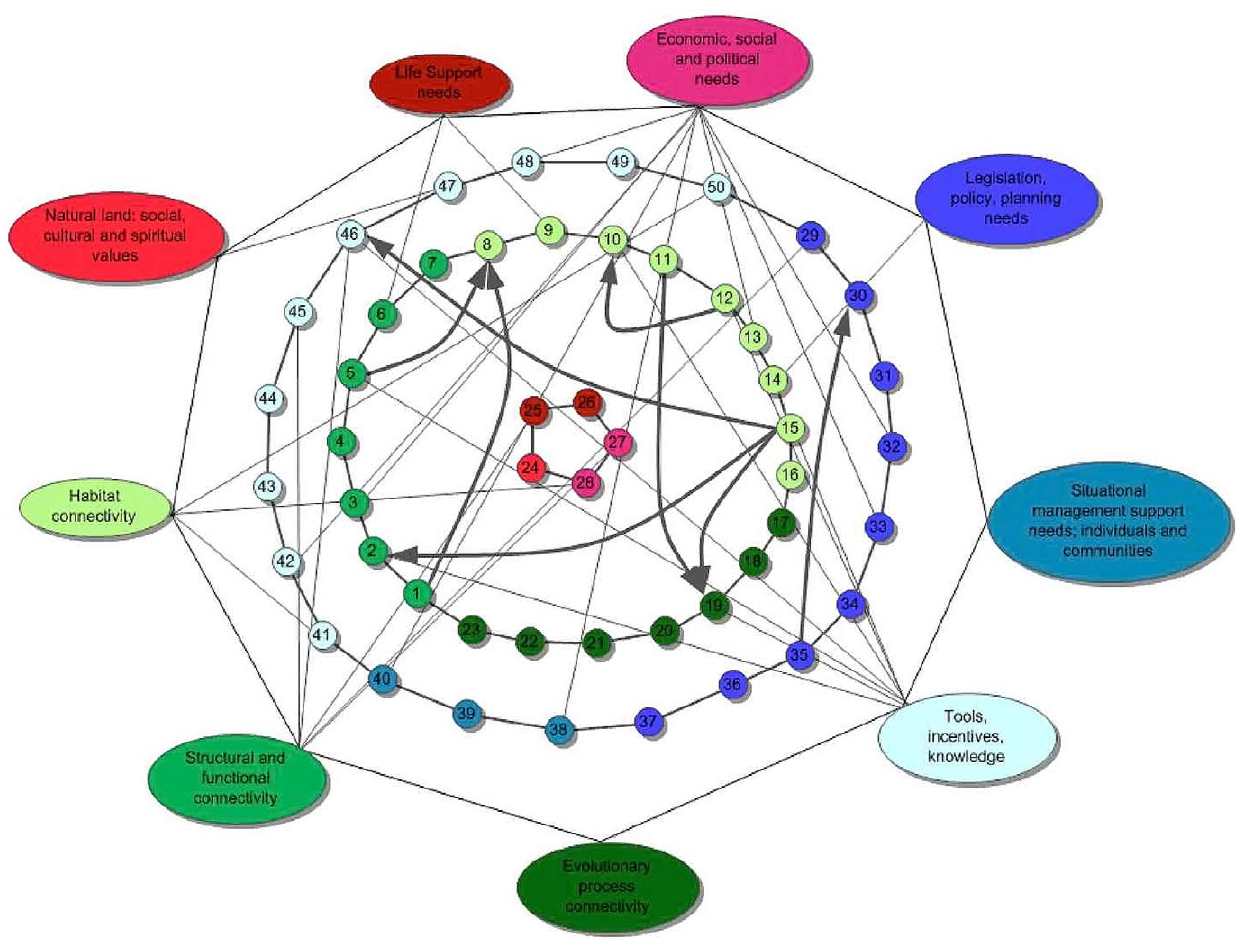
Figure 1. Web of the 50 most urgent questions concerning an ecological continuum in the European Alps. The nine sub-topics of the three context areas (nature: green; people: red; management: blue) mark the edges of the web. The questions of each context area are interlinked and marked in the same colour as the sub-topics they were assigned to. Questions (numbers; see text) which also address another context area are further linked with a second sub-topic, highlighting the interactions. Bold arrows indicate that one or more questions need to be solved before a subsequent question can be answered.